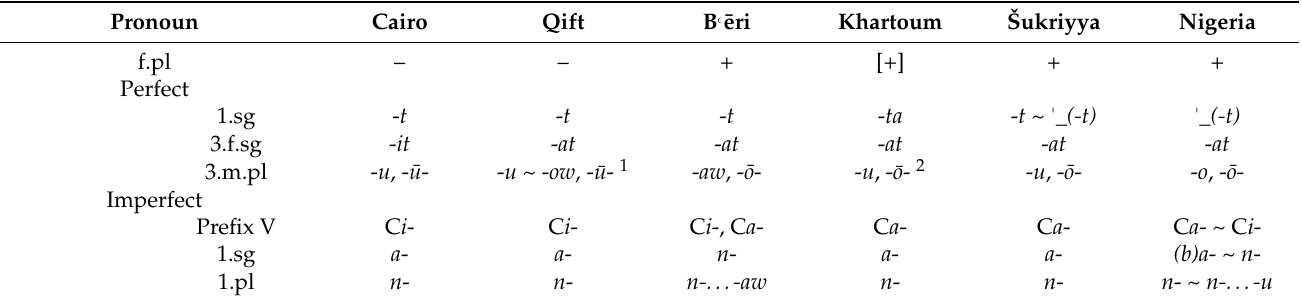
Table 6. Verbal Agreement